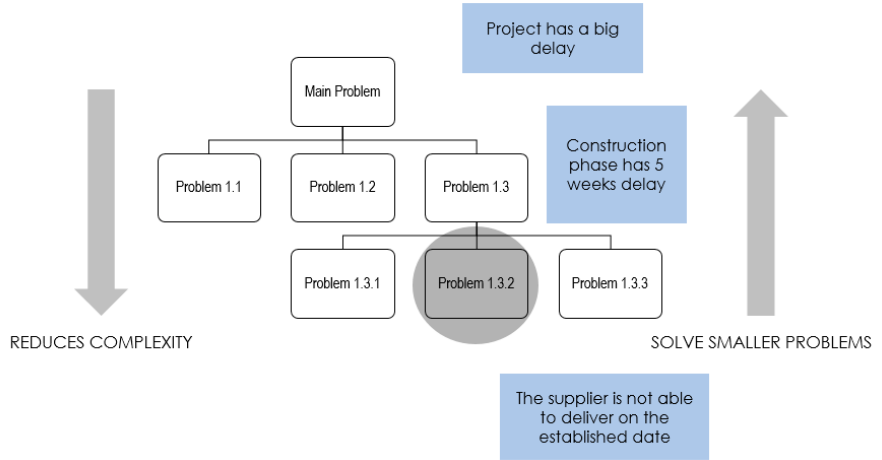
Figure 9. Decomposition Technique of a Problem in Sub-Problems (authors).